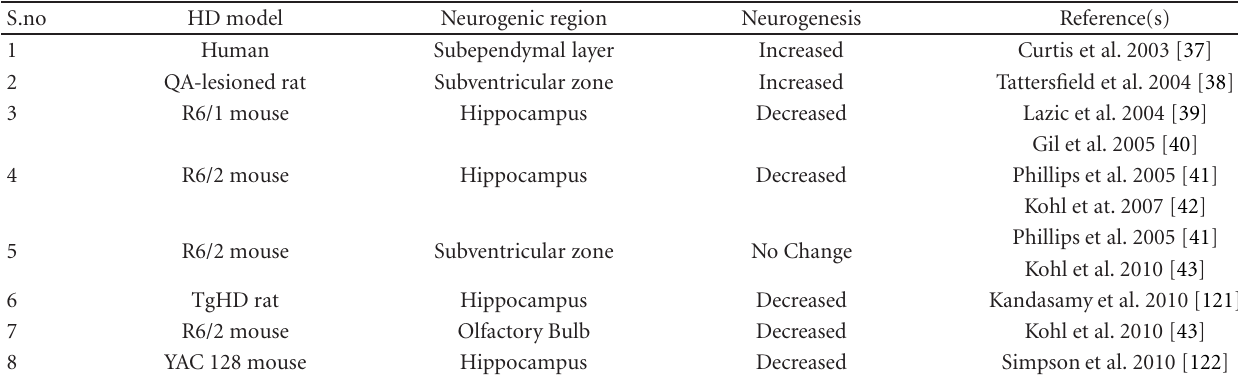
Table 1: Adult neurogenesis in HD patients and rodent